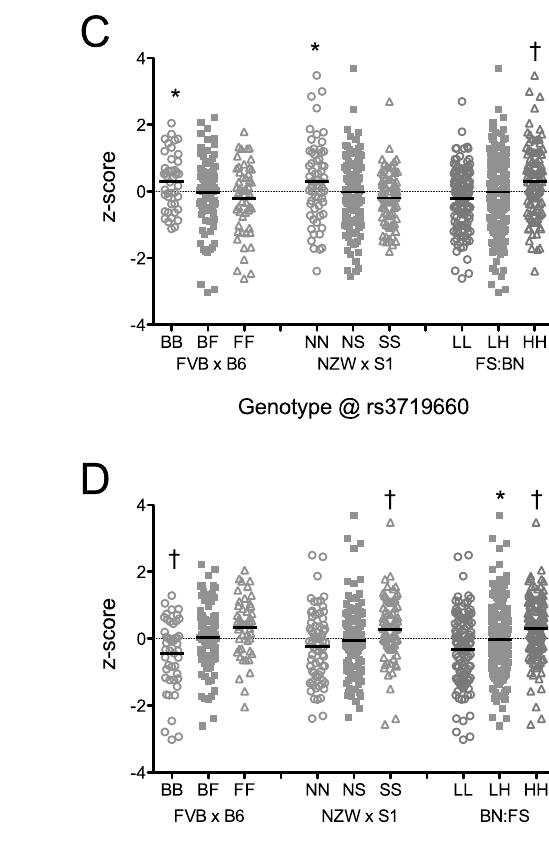
Fig 4. Novel QTL for pre-training exercise time identified on Chromosomes 12 and 14 using combined cross analysis. LOD score plots for pre- training exercise time on Chromosome 12 (A) and 14 (C) are shown for FVB x B6 F 2 (dashed line), NZW x 129S1 F 2 (dotted line) and combined cross (sold line). Horizontal dashed line represents significant (P = 0.05) LOD threshold for the combined cross. Allele effect plots for QTL for pre-training exercise time on Chromosomes 12 (B) and 14 (D). The y-axis in each graph is the z-score transformed exercise time and the x-axis indicates cross-specific genotypes. Homozygous S1, NZW, FVB, and B6 are denoted “ SS ” , “ NN ” , “ FF ” , and “ BB ” , respectively. Heterozygous alleles are denoted “ NS ” and “ BF ” in individual crosses. For combined cross analysis, genotypes were re-coded as “ HH ” for high performing strains and “ LL ” for low performing strains, and “ LH ” for heterozygotes. The strain pattern for high and low performing strains is indicated below allele effect plot for each combined cross QTL. Allele effects are shown at the peak location for each QTL. The solid black line for each genotype represents the mean. * , P < 0.05 compared with alternate homozygous genotype (e.g., BB vs. FF); † , P < 0.05 compared with other genotypes.